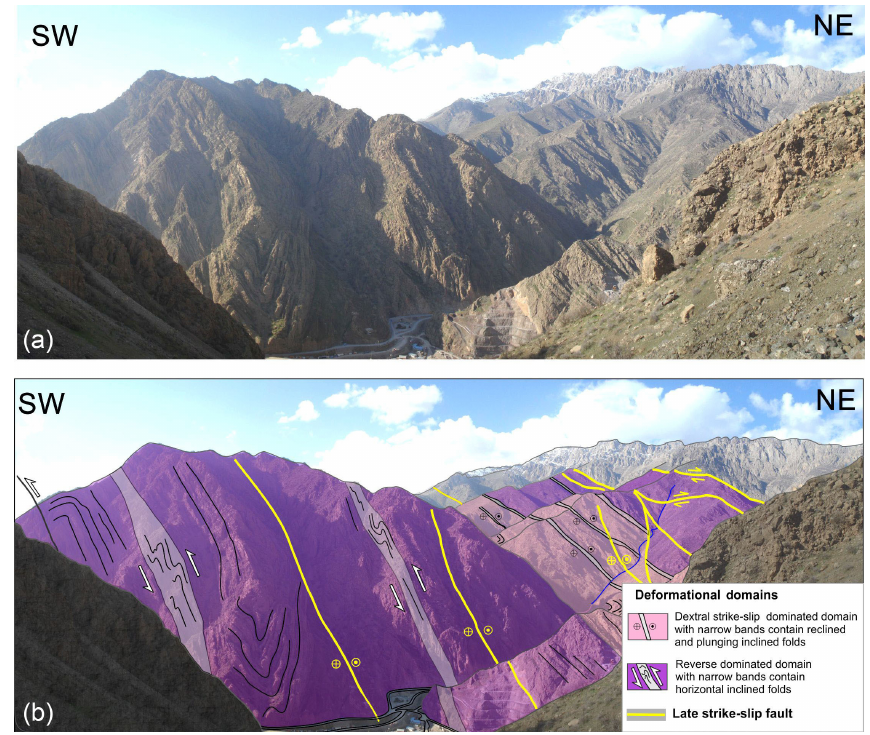
Figure 10. Field photo and line drawing of the Radiolarite zone near the city of Nodeshe (Fig. 9b). Note that the dextral strike-slip dominated domain (pinkish color area) is located within the reverse dominated domains.